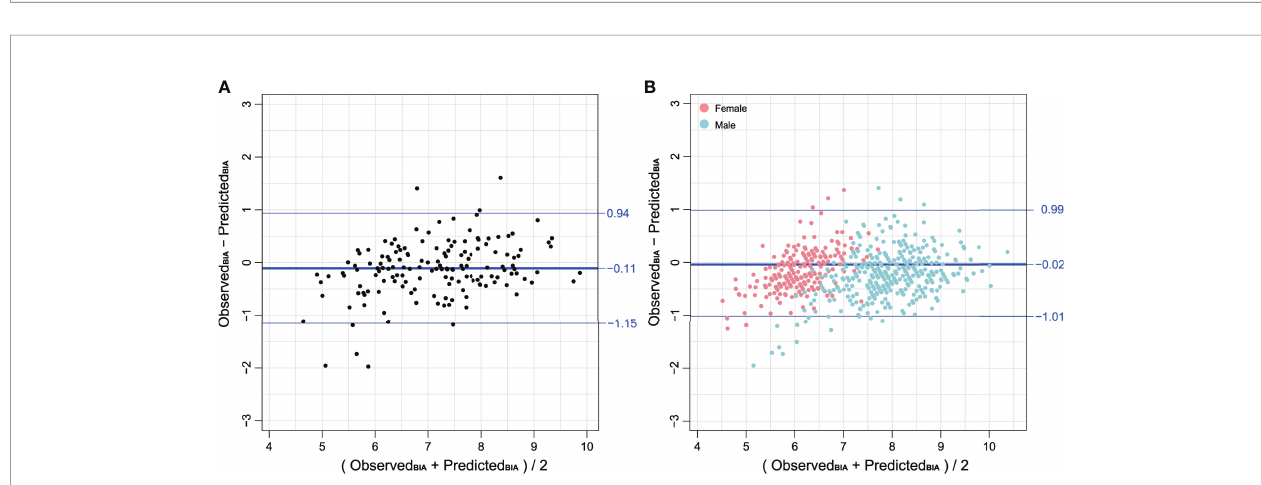
FIGURE 3 | (A) Bland – Altman plot comparing BIA derived from T12-ESA and observed BIA in the validation group composed of 152 cases. (B) Bland – Altman plot comparing BIA derived from T12-ESA and observed BIA in all cases strati fi ed by sex. Female cases are represented in red and male cases are represented in blue. Note: BIA units are kg/m 2